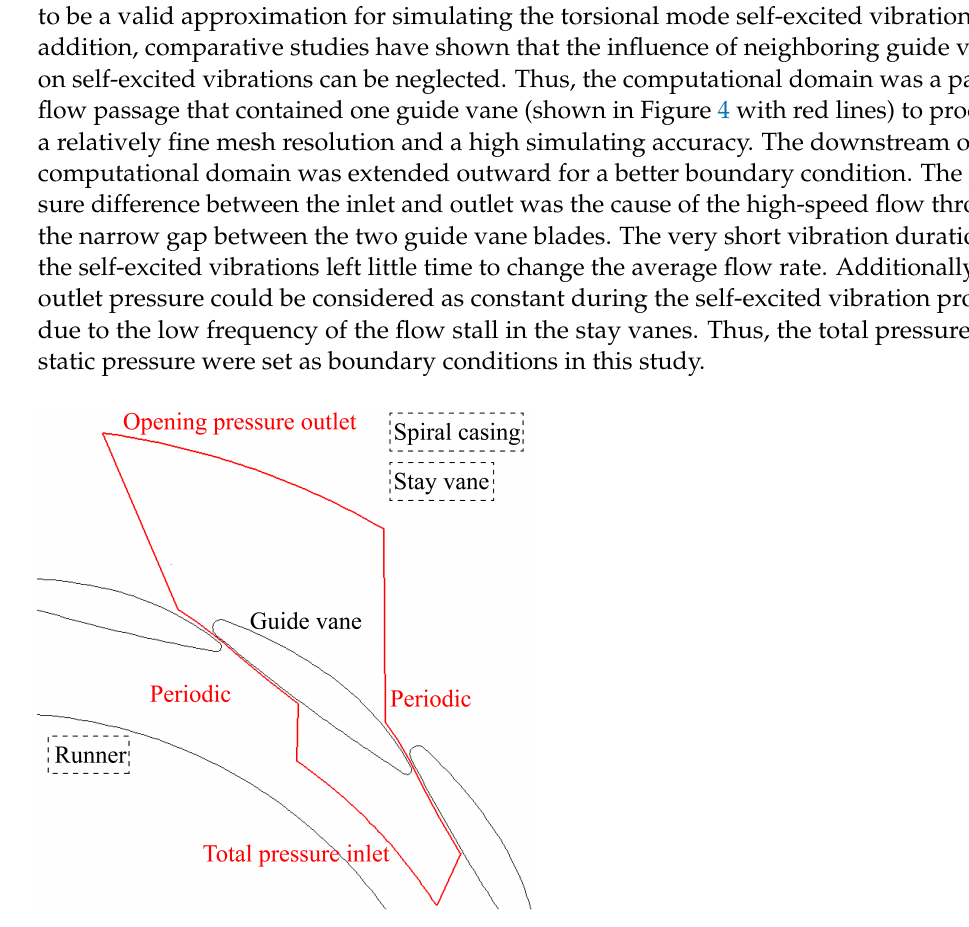
Figure 4. The computational domain of the guide vane for the 2D URANS-1DOF coupling